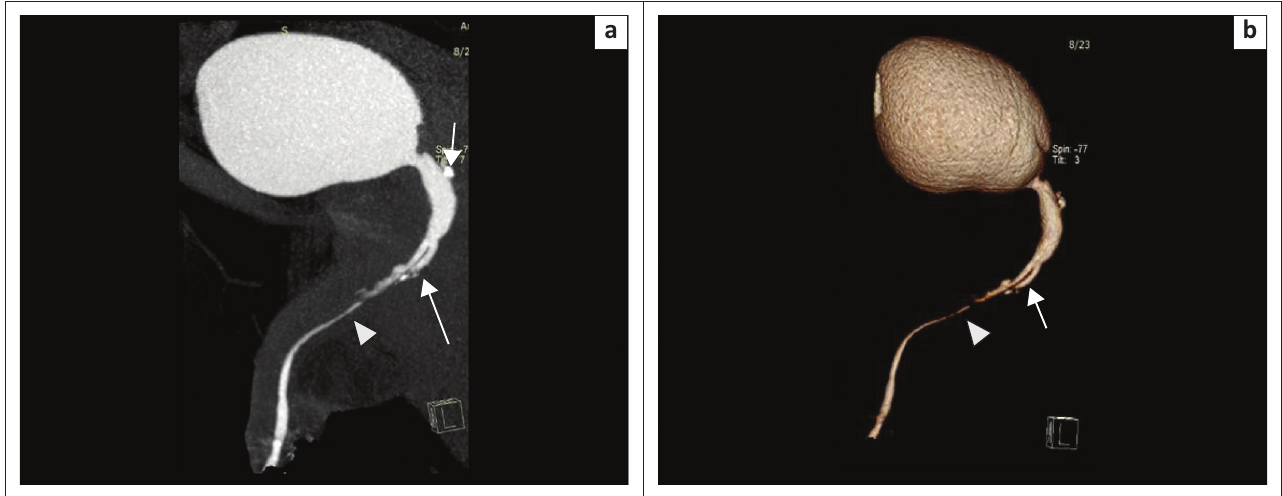
FIGURE 8: (a) Sagittal maximum intensity projection image showing a partial penobulbar stricture (arrowhead), anterior urethritis, with a false tract in the bulbar urethra (long arrow), cystitis and prostatic calcification (short arrow). (b) Volume rendered technique image showing partial penobulbar stricture (arrowhead) and anterior urethritis, with a false tract in the bulbar urethra (long arrow).